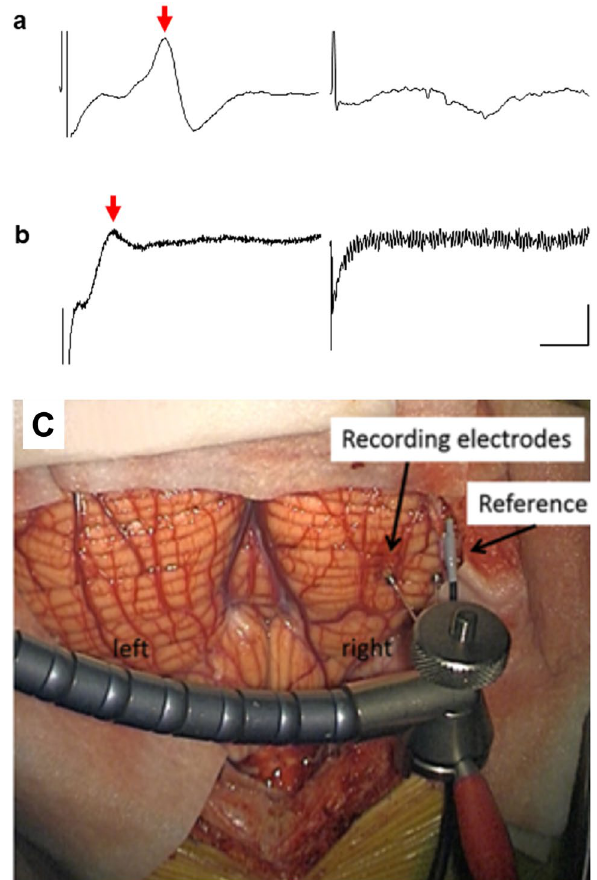
Figure 1. Cerebellar evoked potentials recorded from two patients. ( a ) Evoked cerebellar potential (arrow) recorded the right inferior posterior lobe in response to single pulse stimulation of the right tibial nerve from patient S2. The trace on the right shows lack of response from the same recording position following stimulation of the right median nerve. ( b ) Evoked cerebellar potential (arrow) recorded from the left posterior lobe from S6 in response to a train of stimuli (9 square pulses 0.5 ms, 10 ms interval, 2.7 Hz) delivered to the left forearm. The trace on the right shows no response to the same stimulus train from an adjacent cerebellar recording site. The trace from S2 is an average of 30 consecutive trials. The trace from S6 is an average of approximately 100 trials. Voltage scale bars = 10 µV in ( a ), 5 µV in ( b ); time base = 10 ms. ( c ) A photograph demonstrating the recording site in the right inferior posterior cerebellum from which an evoked potential was recorded from